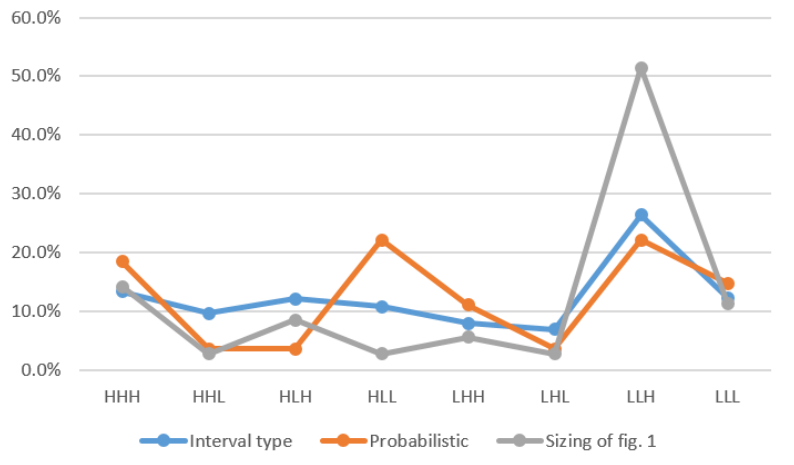
Figure 3. Frequency of each interval type, and frequency of failures for the probabilistic dimensioning method and the sizing of Figure